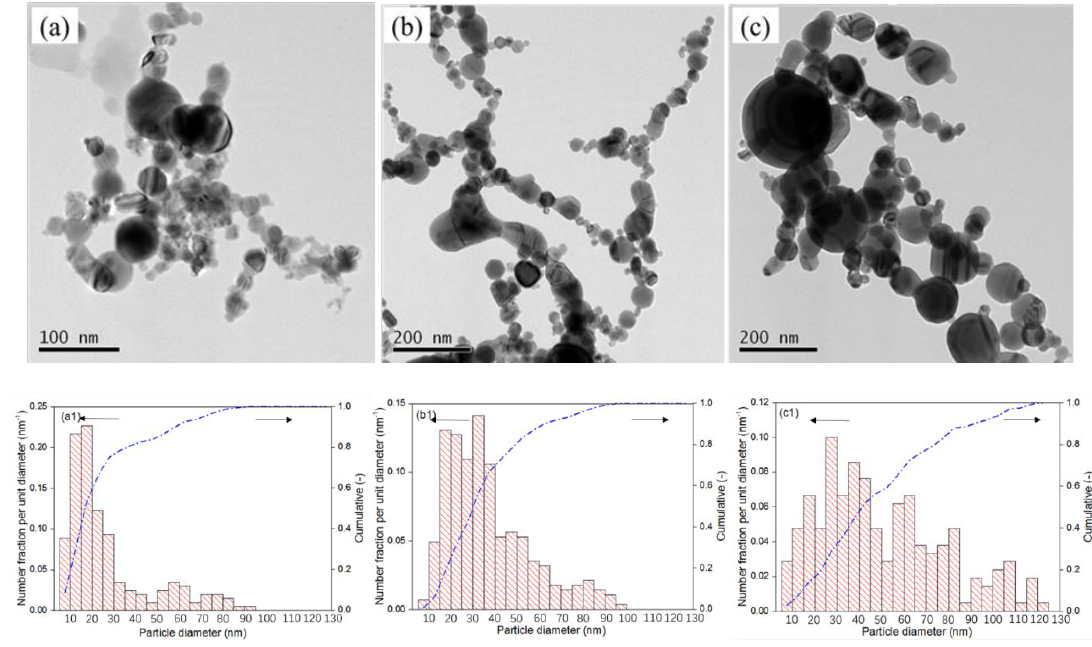
Figure 7. TEM images of nickel nanoparticle in argon arc in different concentrations of hydrogen. ( a ), ( b ), and ( c ) correspond to hydrogen concentrations of 0, 30, and 50 vol%, respectively. ( a1 ), ( b1 ), and ( c1 ) represent the particle size distributions.